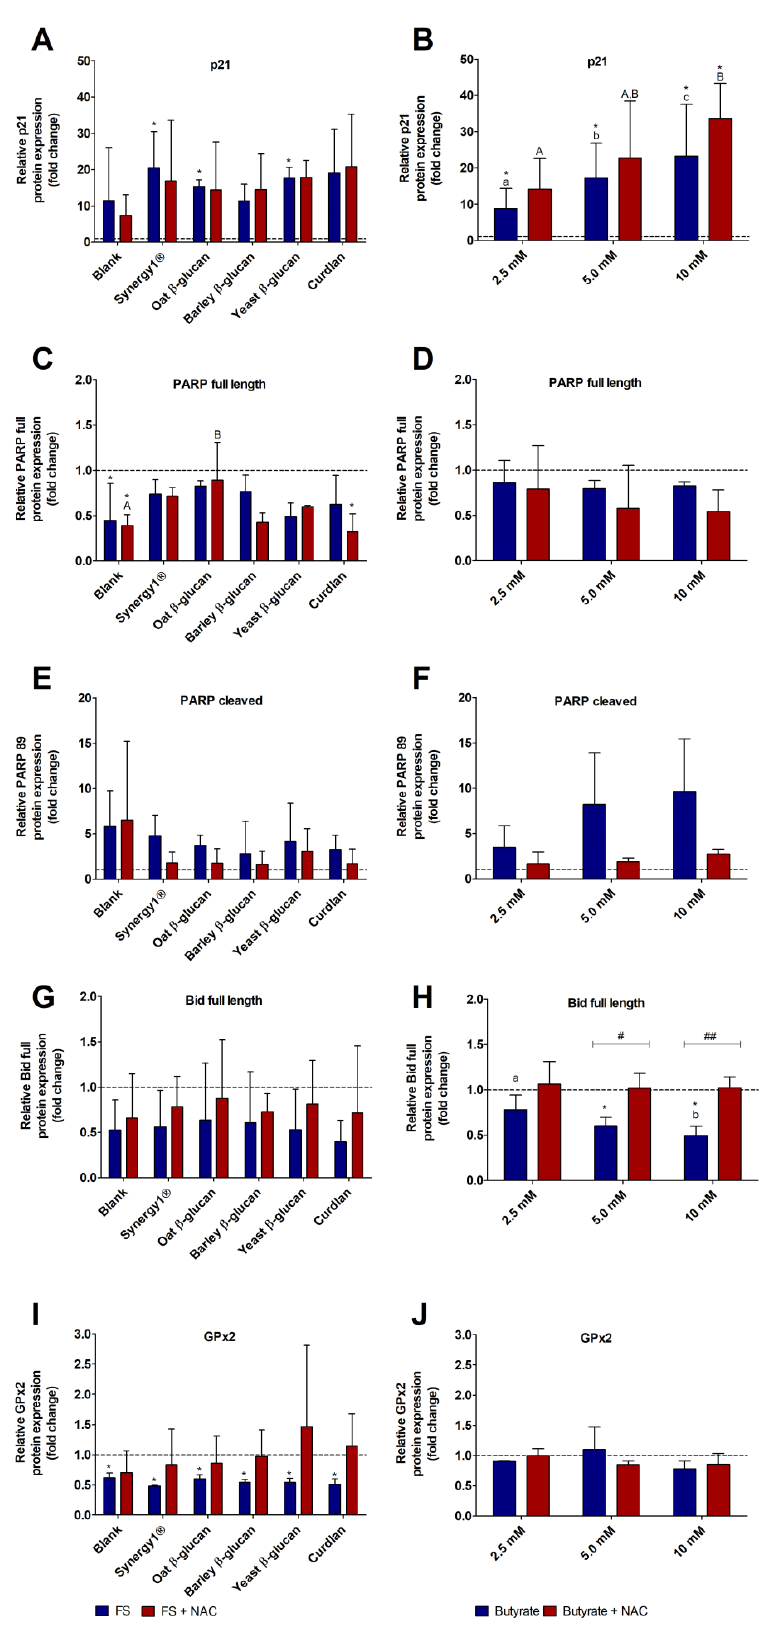
Figure 5. Relative protein expression of p21 ( A , B ), full-length PARP ( C , D ), cleaved PARP (89 kDa) ( E , F ), full-length Bid ( G , H ), and GPx2 ( I , J ) in HT29 cells after treatment with FS (5%) obtained from the